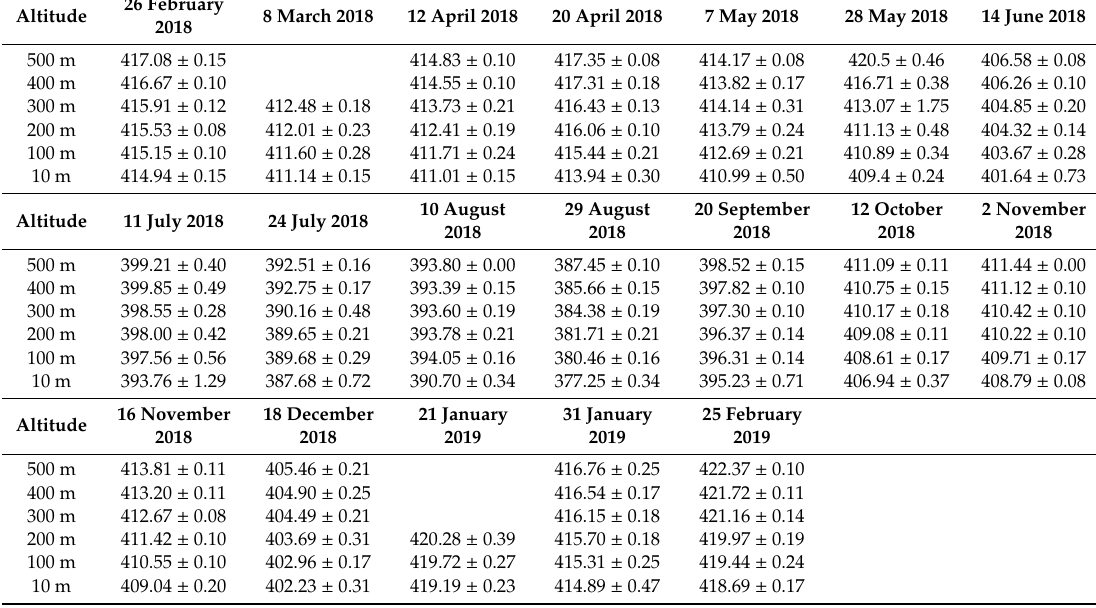
Table A3. CO 2 concentrations (mean ± standard deviation) in ppm, measured by the UAV system at each altitude during its decent from winter 2018 to winter